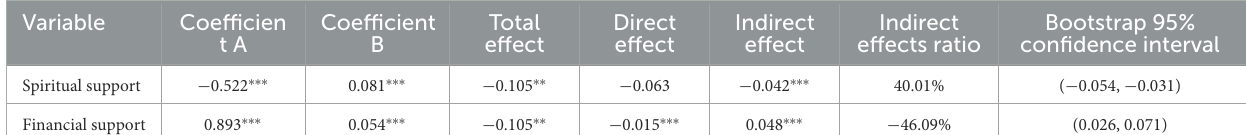
TABLE 9 Sobel vs. bootstrap test